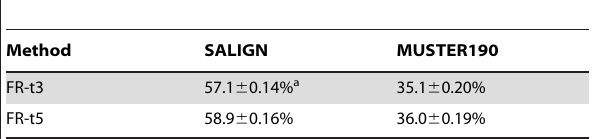
Table 2. The benchmarking of the sensitivity of FR-t5 and FR- t3 on Lindahl